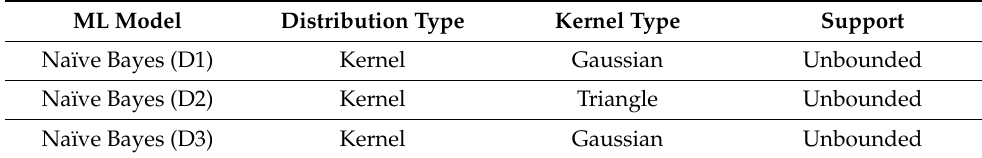
Table A4. Naïve Bayes: optimized hyperparameters for each dataset.